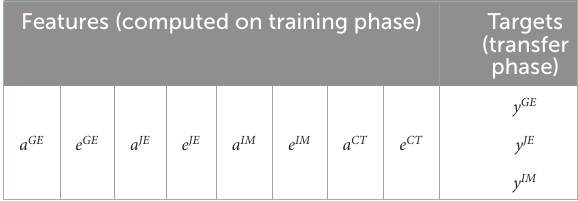
TABLE 1 Set of 8 features used for prediction of the 3 targets ( y I , I = { GE , JE , IM }